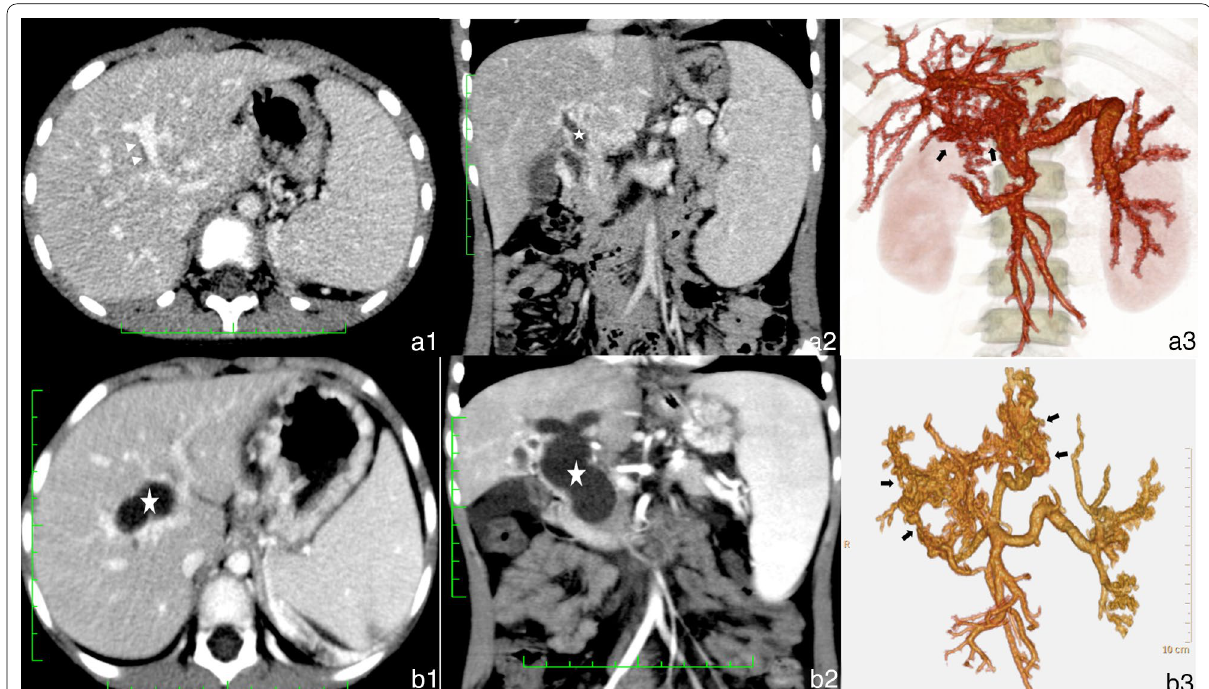
Fig. 4 a Male patient aged 7 years. Extrahepatic portal vein obstruction (EHPVO) combined with bile duct dilation. a1, a2 Bile duct dilation (white triangle) next to the portal vein and dilation of the common hepatic duct (white star). a3 Volume rendering (VR) showed cavernous transformation (black arrow). b Female patient aged 5 years. EHPVO combined with a common bile duct cyst. b1, b2 Dilation of intrahepatic bile duct and common bile duct (white star). b3 VR showed cavernous transformation (black